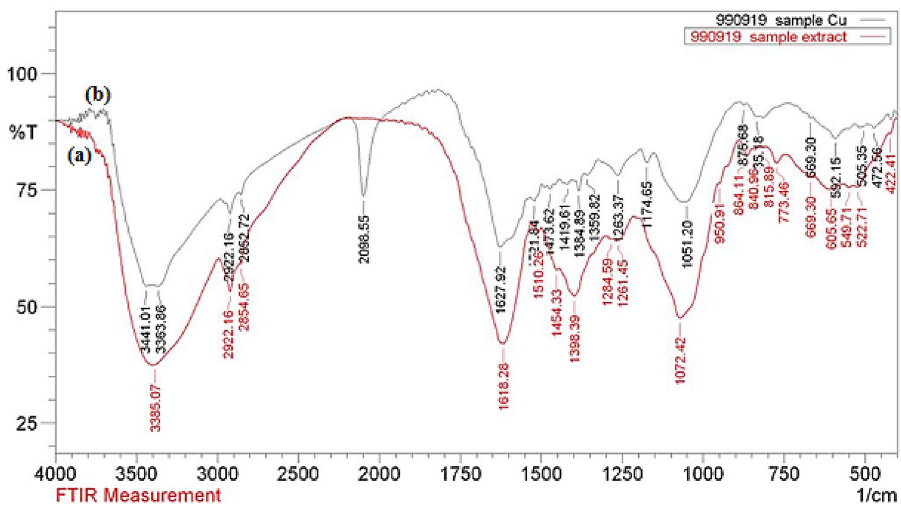
Figure 4. FT-IR spectrum of aqueous extract of Stachys lavandulifolia ( a ), and green synthesized CuO NPs ( b ).